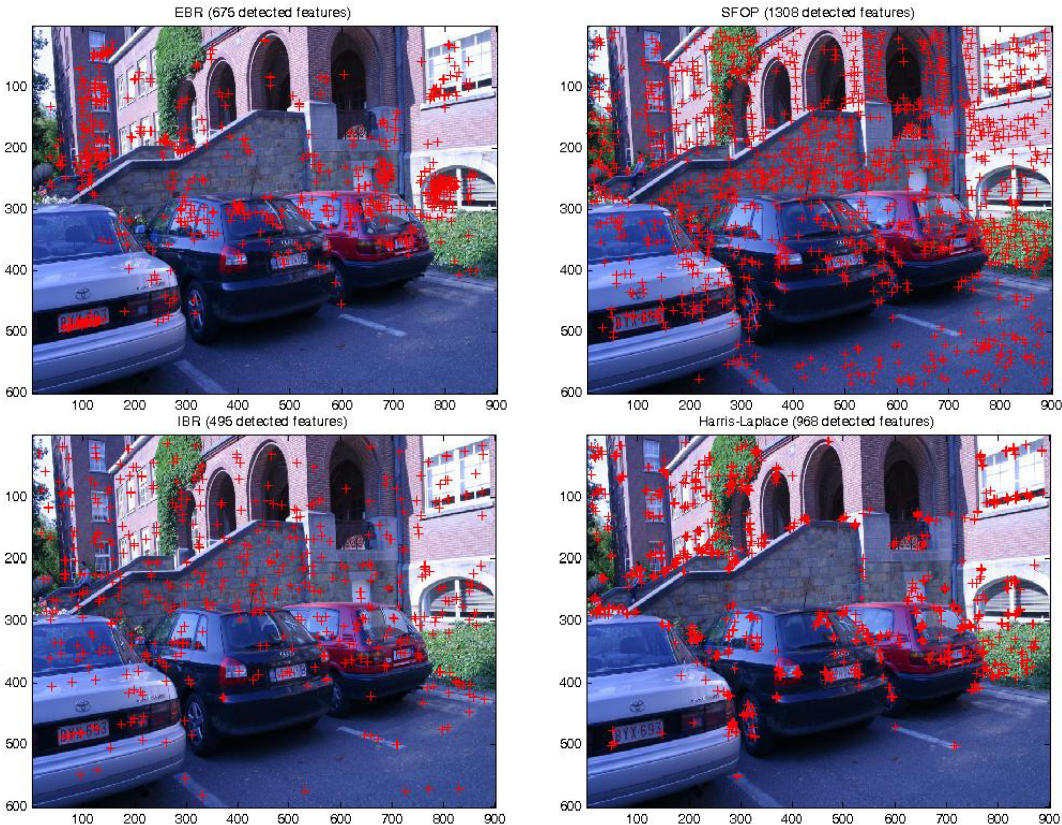
Figure 3. Actual detector responses for image 1 of the Leuven dataset [21]. From top left to top right: EBR and SFOP; from bottom left to bottom right: IBR and